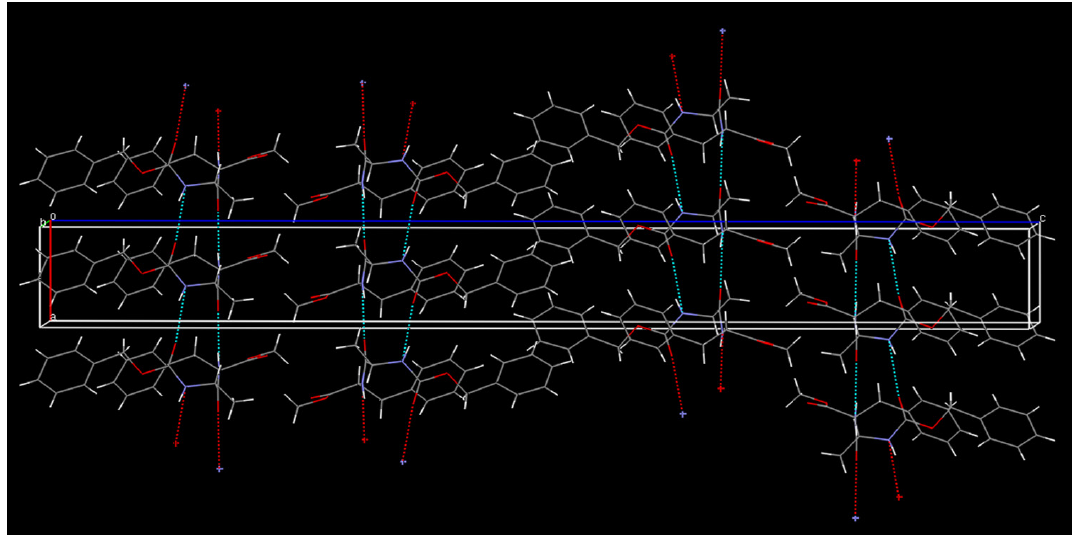
Figure 3. A packing diagram of Z-AF-OMe with view onto the ac plane. Hydrogen bonds are drawn as dashed